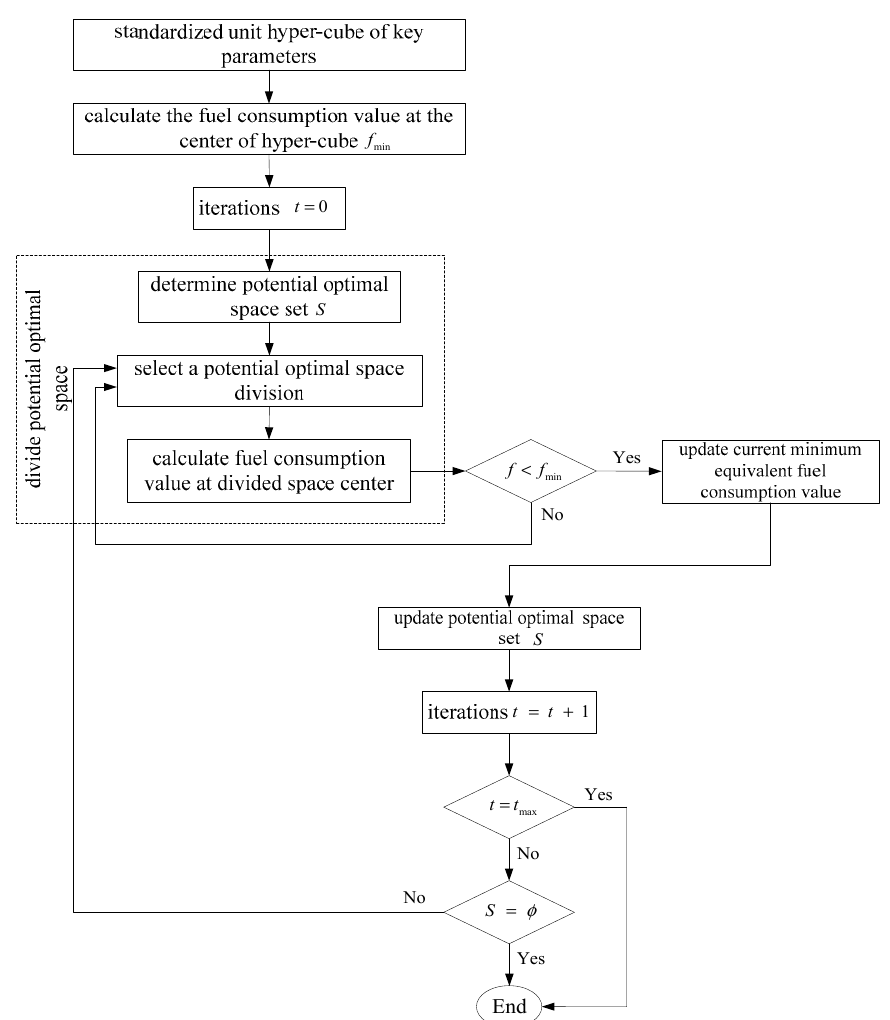
Figure 18. Optimization procedure of key parameters for HEV energy management using DIRECT algorithm.